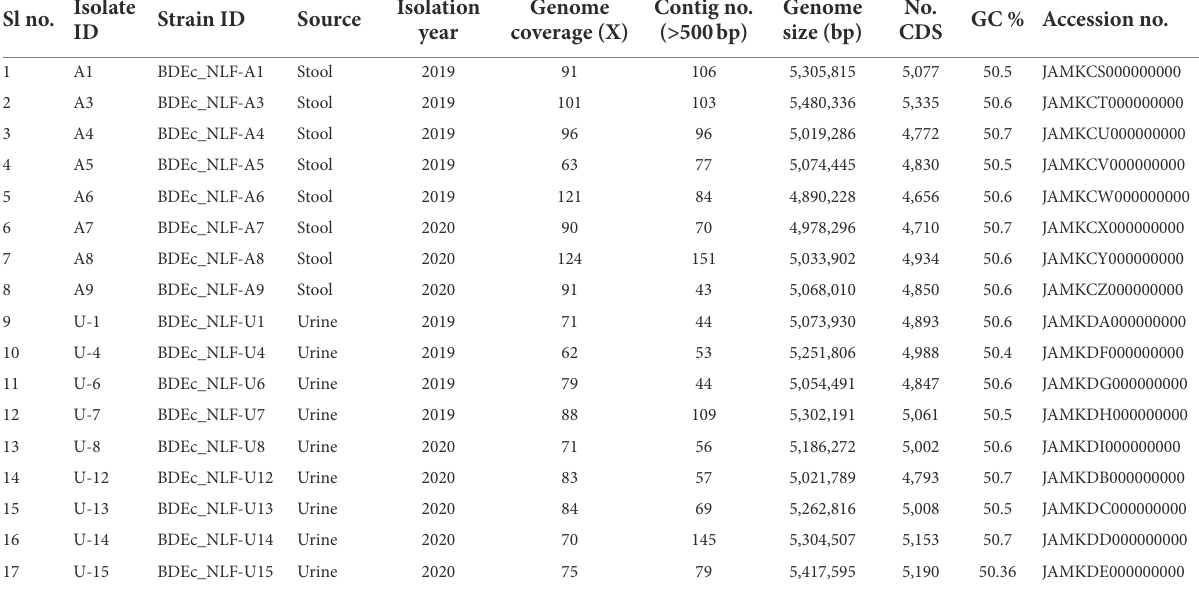
TABLE 2 Genomic features of the 17 whole-genome sequenced NLF E. coli isolates. Isolate Sl no.